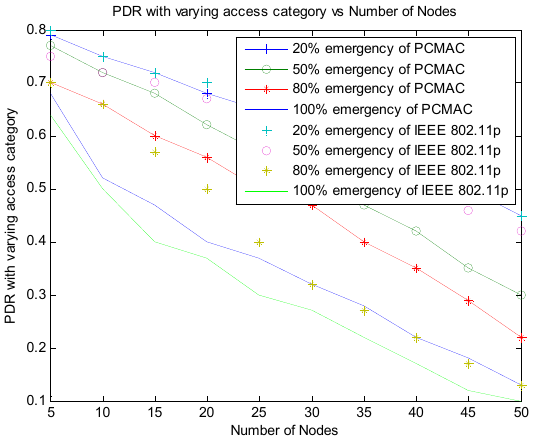
Figure 13. Comparison of PDR of PCMAC and PDCMAC with varying emergency packets.